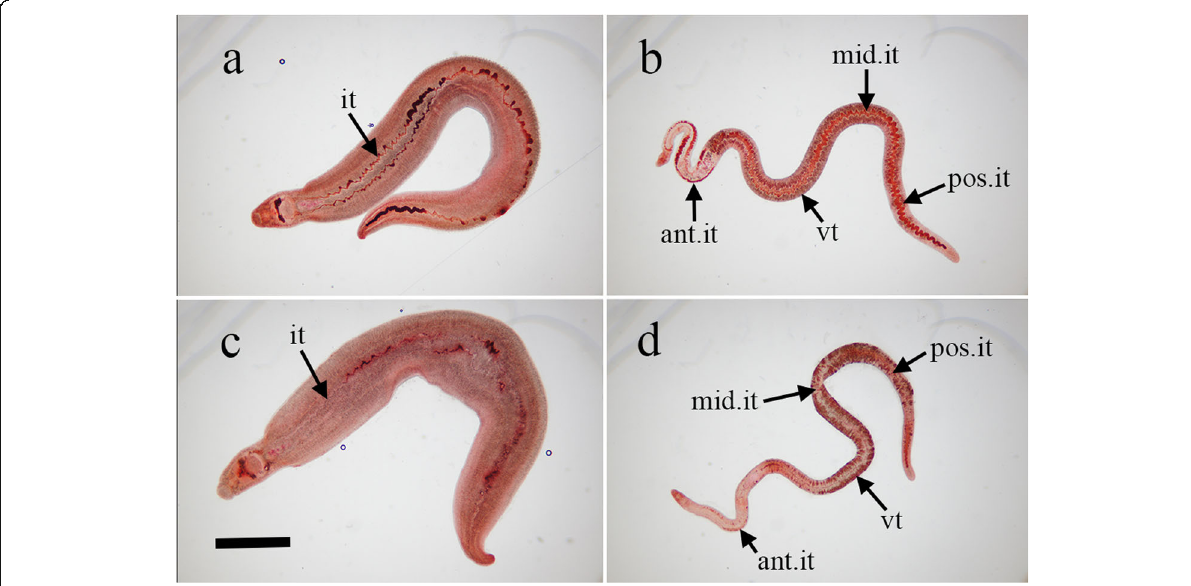
Fig. 2 Neutral red staining of Schistosoma mansoni adult worms incubated with febrifugine. Male and female S . mansoni adult worms were incubated with none (male: a , female: b ) or 0.5 μ g/ml febrifugine (male: c , female: d ) for 5 days and stained with neutral red. it intestinal tract, vt vitellaria, ant . anterior, mid . middle, pos . posterior. Scale bar = 1